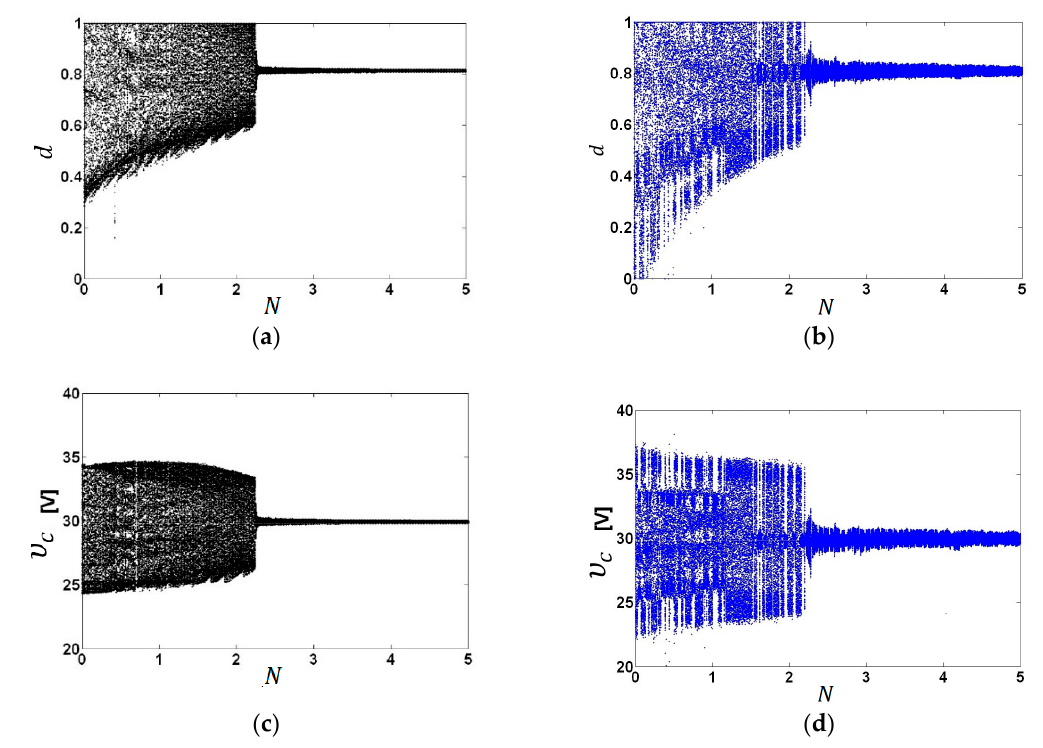
Figure 15. Bifurcation diagrams for the simulation and experimental test of the system with ZAD ( K S 3 = 35) and FPIC, changing the parameter N with K S 1 = K S 2 = 2 and a 2T delay period: ( a ) d vs. N for the simulation test; ( b ) d vs. N for the experimental test; ( c ) υ c vs. N for the simulation test; and ( d ) υ c vs. N for the experimental